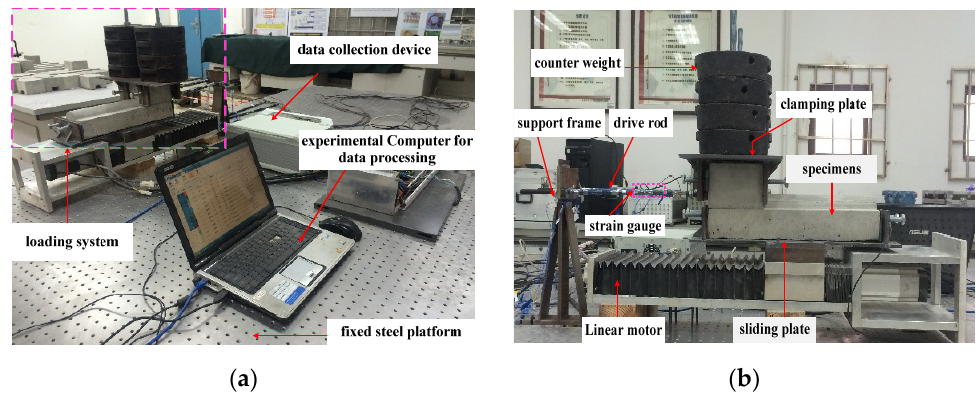
Figure 5. Test setup: ( a ) entire view; ( b ) loading system.